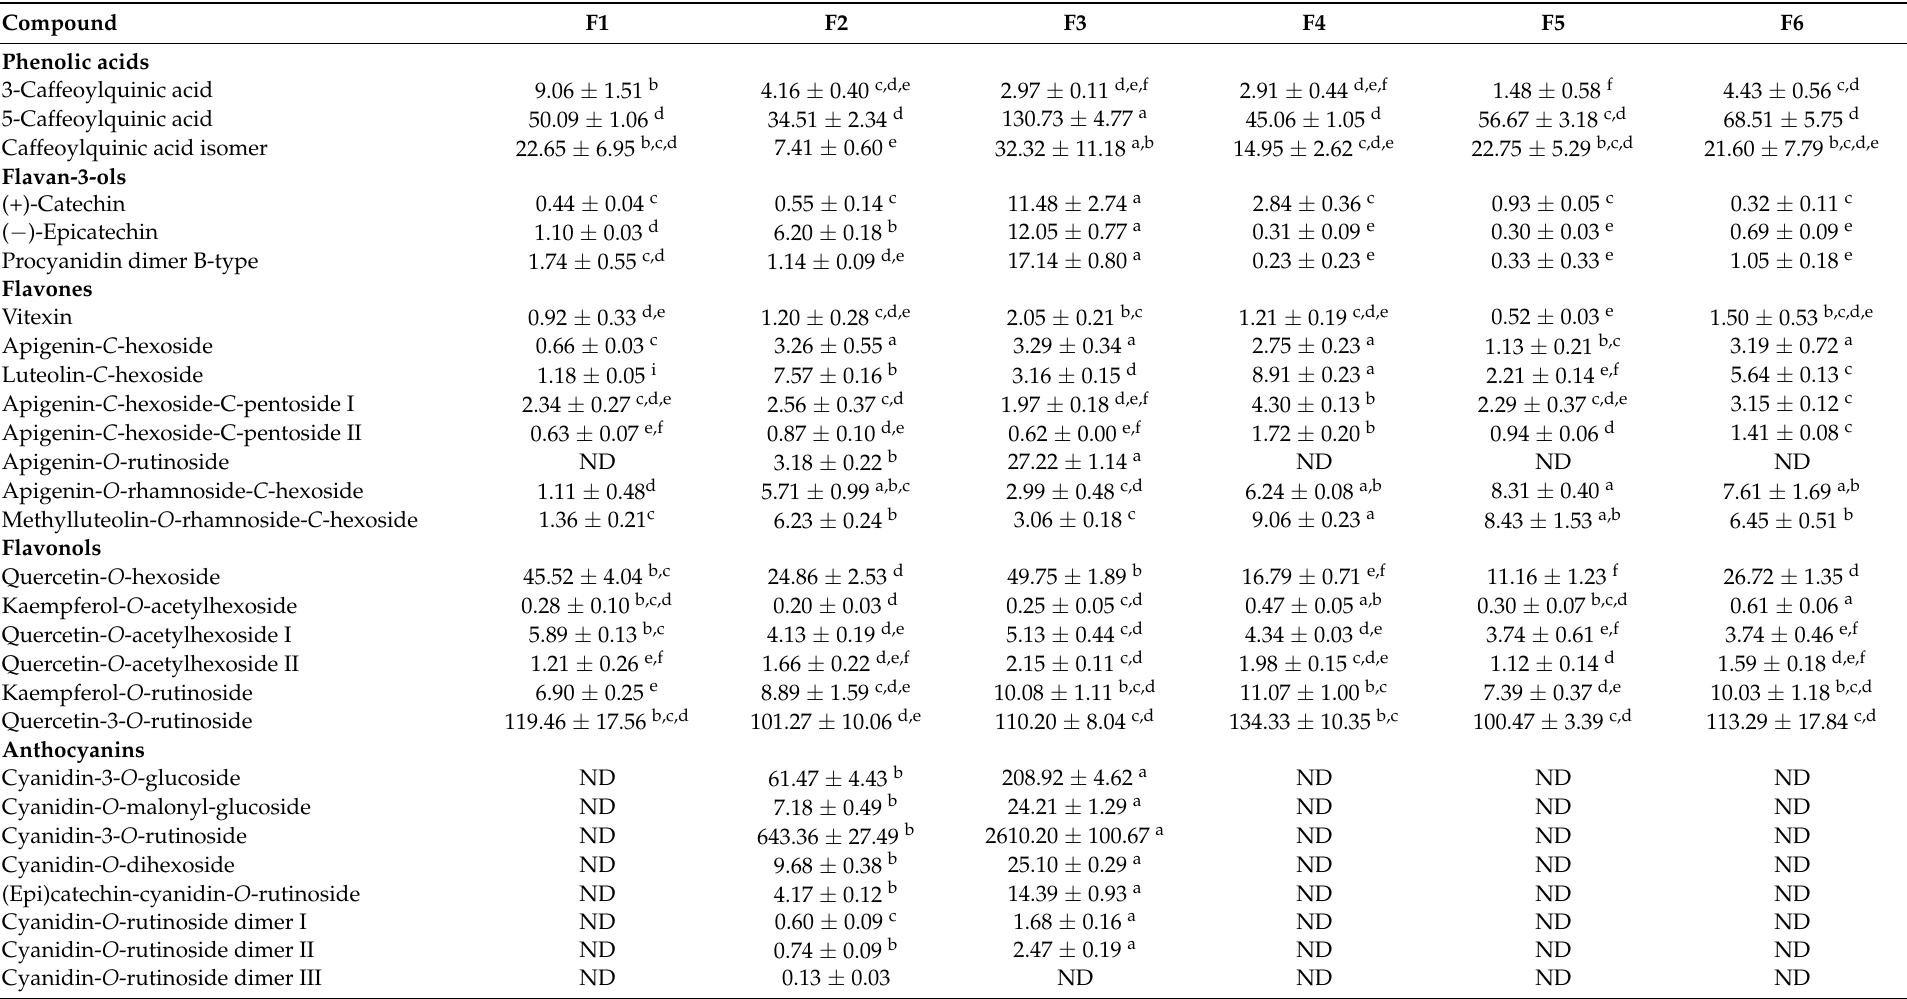
Table 1. (Poly)phenol content in fig